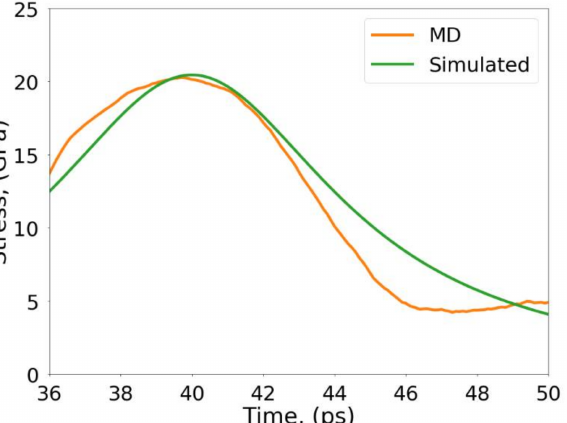
Figure 2. Stress evolution in (001) single-crystal Ta as a function of time under shock loading along with the simulated stress